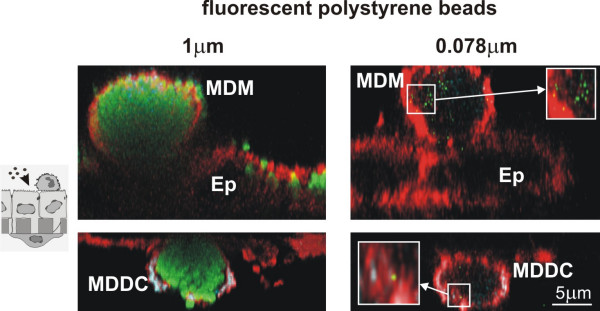
Intracellular particle localisation in tripe cell co-cultures visualised by LSM. Cells at the upper side of the insert (upper row) were stained for CD14 (MDM, turquoise) and F-Actin (all cells, red); cells at the lower side (lower row) for CD86 (MDDC, turquoise) and F-Actin (all cells, red). Fluorescently labelled polystyrene particles (1 μm, and 0.078 μm) are shown in green. MDM and MDDC were filled with particles, considerably fewer particles were found in epithelial cells (Ep). All images represent xz-projections.